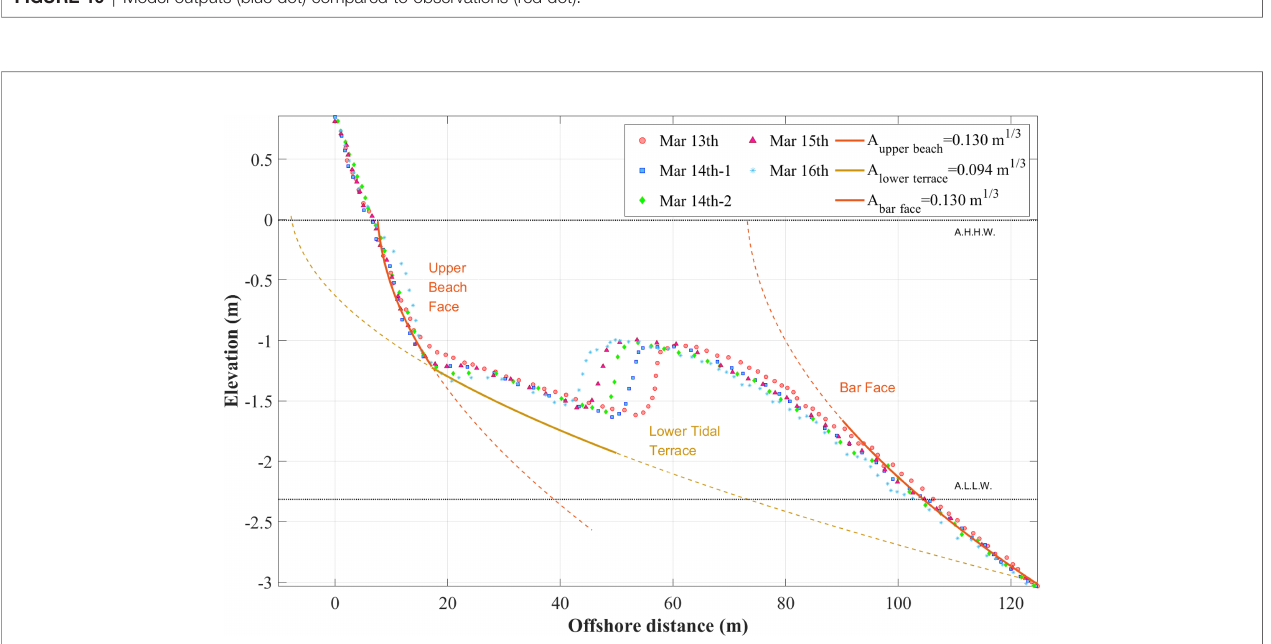
FIGURE 10 | Model outputs (blue dot) compared to observations (red dot).